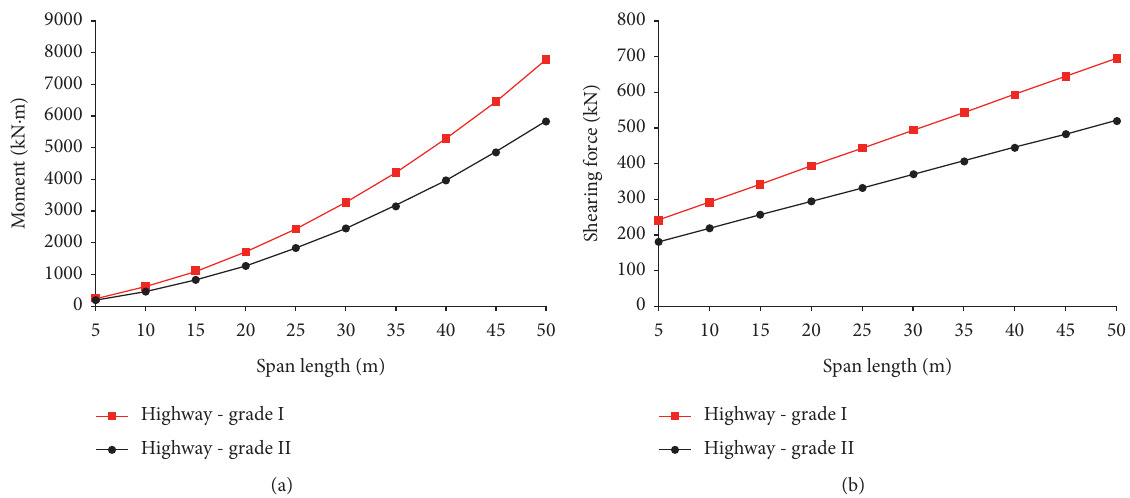
Figure 4: Traffic loading effects in JTG D60-2004: (a) moment and (b) shearing force.